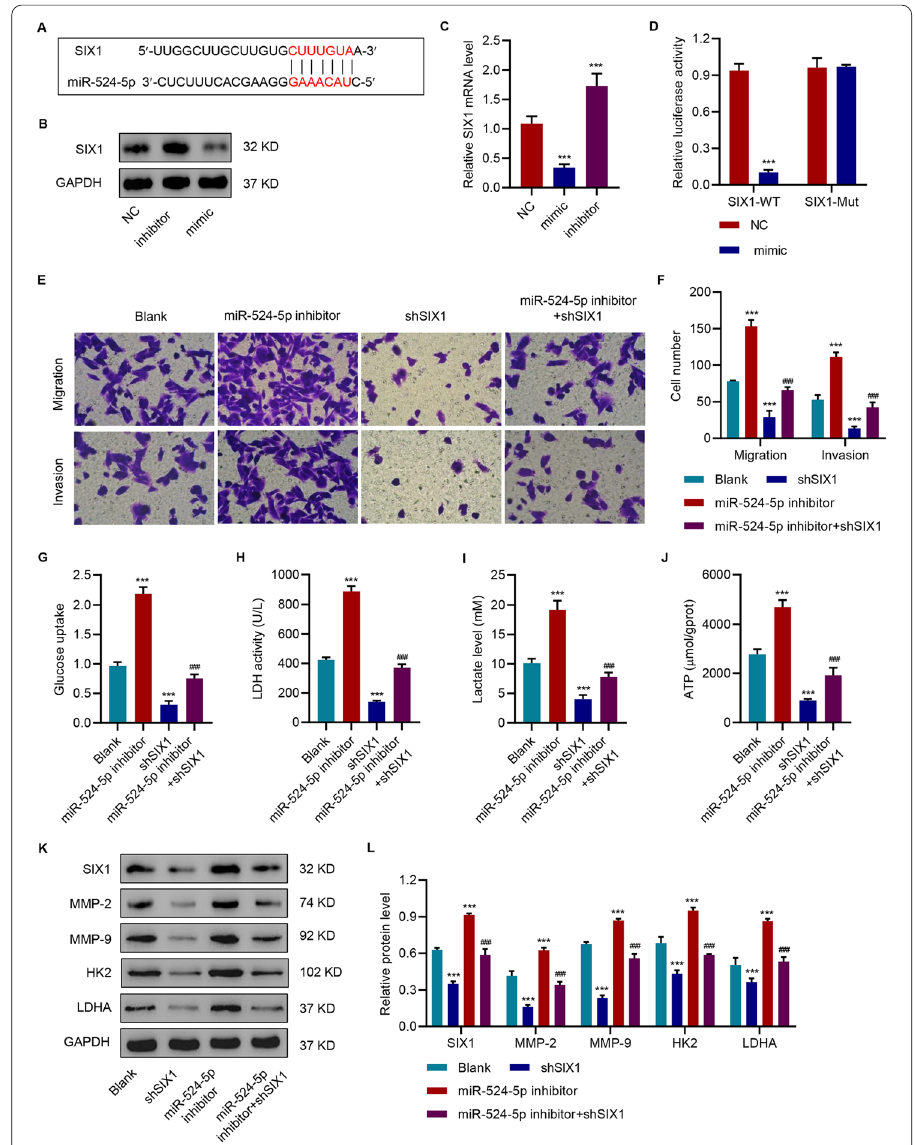
Fig. 5 SIX1 knockdown attenuated miR-524-5p inhibitor-mediated promotion of migration, invasion, and glycolysis. A The predictive binding of miR-524 and SIX1. B , C Levels of SIX1 in HepG2 cells with overexpression or silencing of miR-524. D miR-524 regulated luciferase activity of SIX1 3 ′ -UTR. Effects of miR-524 inhibitor and SIX1 shRNA on ( E , F ) migration/invasion, ( G ) glucose uptake, ( H ) LDH activity, ( I ) lactate, and ( J ) ATP content, and ( K , L ) SIX1, MMP-2, MMP-9, HK2, and LDHA. The data are expressed as the mean (n 3). *** P < 0.001 vs blank or NC. ### P < 0.001 vs miR-524 =